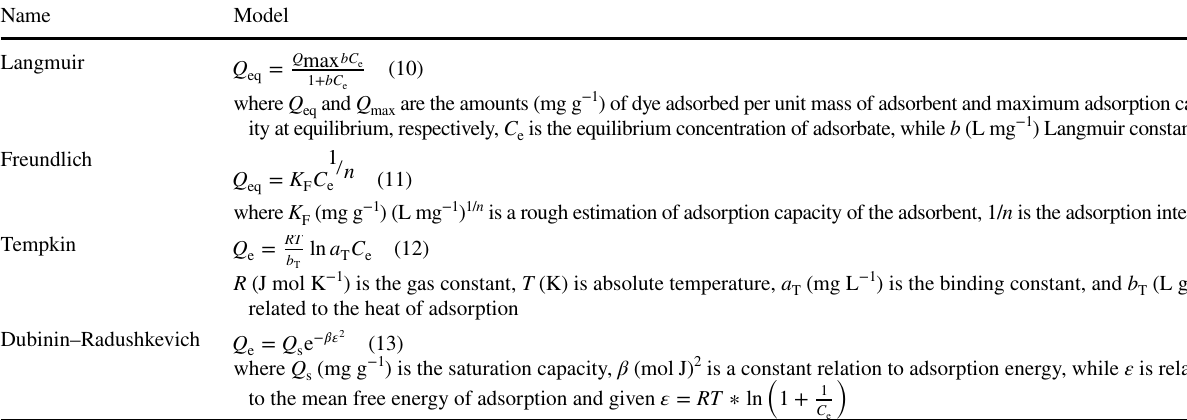
Table 2 Isotherm models applied for the adsorption of studies of CV and